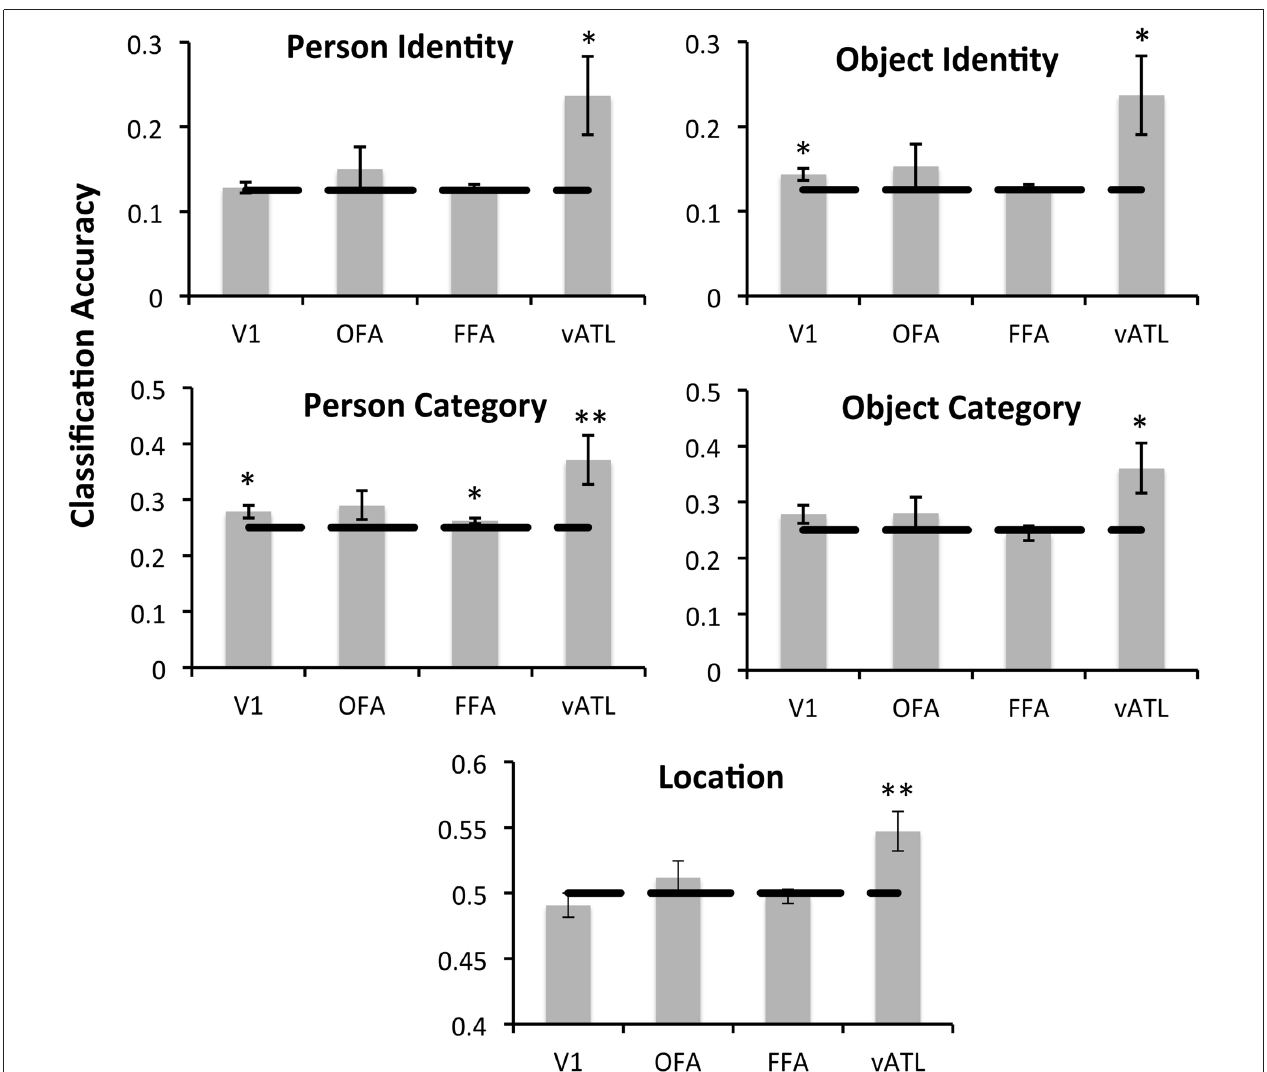
FIGURE 3 | The classification accuracy of each face-network regions of interest (ROI) for facial identity, facial occupation, object identity, object category, and location as assessed by the MVPA analysis. The dashed line represents chance performance (face/object identity = 0.125, face/object category = 0.25, location = 0.5). Single asterisks ( ∗ ) indicate significant above-chance classification accuracy at an uncorrected threshold as indicated by a one-tailed t -test ( p < 0.05). Double asterisks ( ∗∗ ) indicate above-chance classification accuracy that survives a Bonferroni correction for multiple comparisons ( p < 0.0125). All face-selective ROIs were located in the right